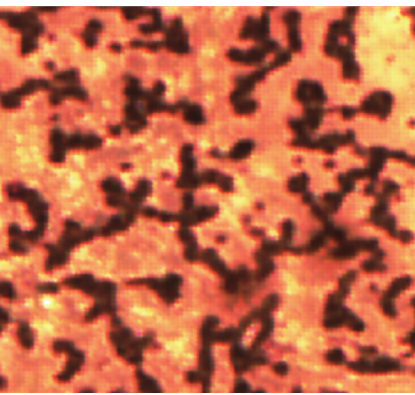
Figure 1: MGG peripheral blood film ( × 40); Histoplasma capsula- tum scattered within red blood cells, with an eccentric chromatin and surrounded with a clear halo.